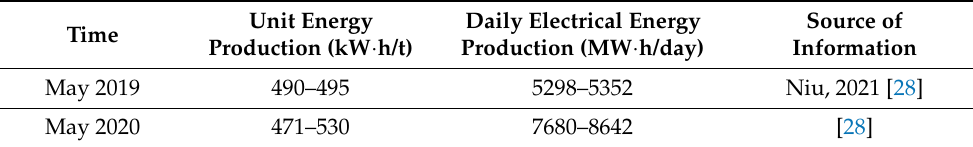
Table 2. The incineration electric energy production per day in Shanghai before and after the July 2019